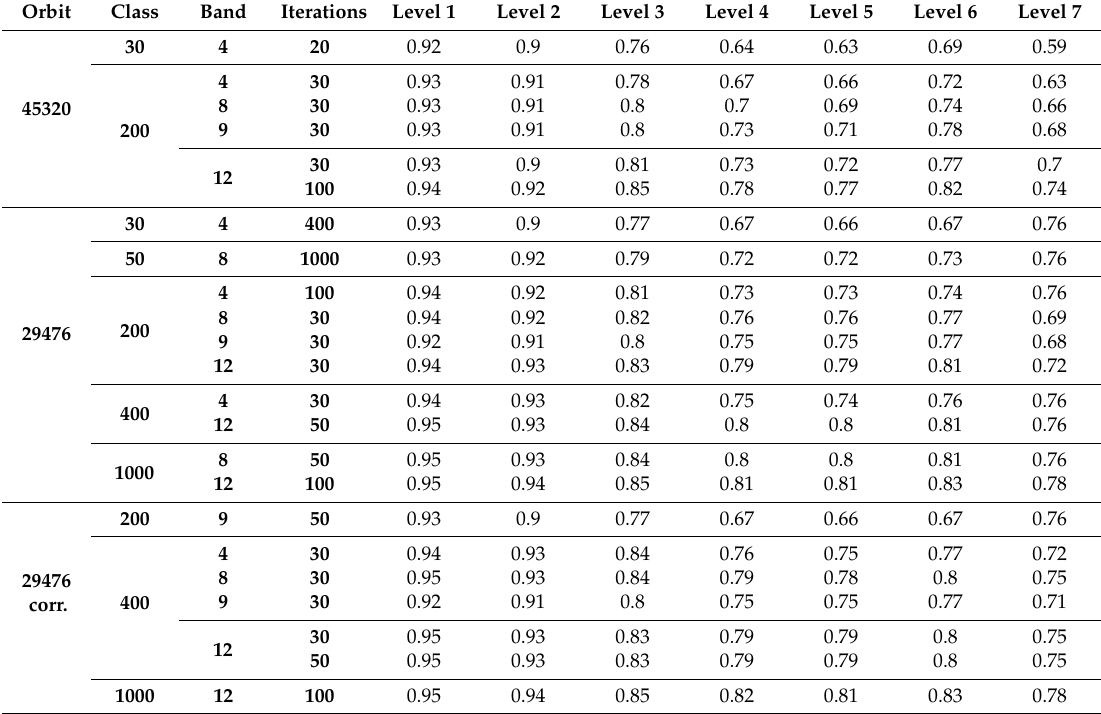
Table 2. OA classification results.